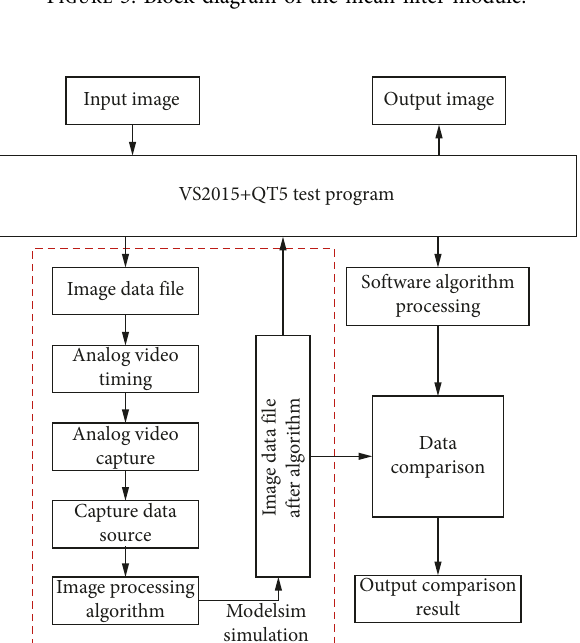
Figure 5: Block diagram of the mean filter module.